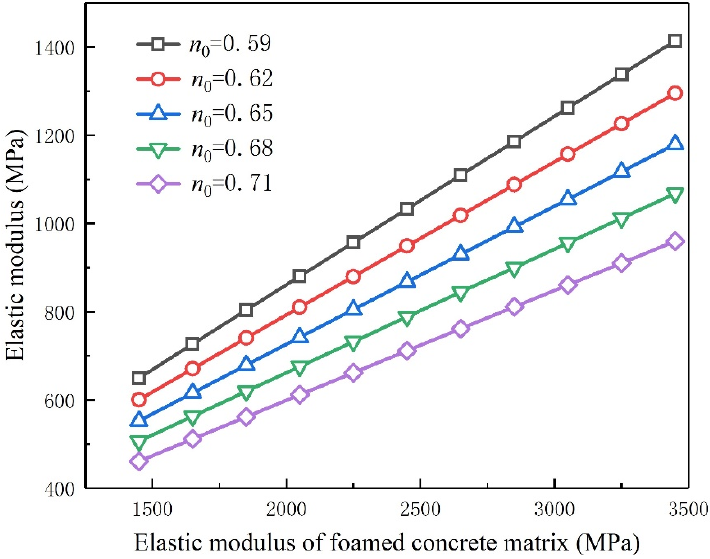
Figure 16. Variation law of the elastic modulus of foamed concrete with the elastic modulus of matrix .